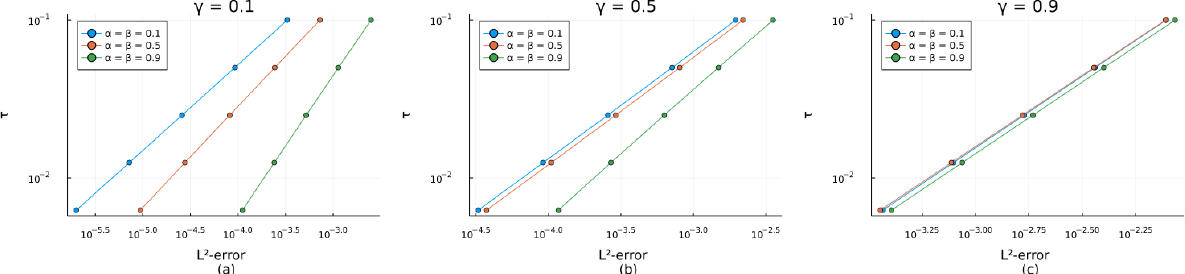
Figure 1. Error plots with respect to the time step τ obtained for Example 1 with h = 1/20,000 and different orders of fractional derivatives: α ∈ { 0.1,0.5,0.9 } ; β = α ; ( a ) γ = 0.1. ( b ) γ = 0.5. ( c ) γ = 0.9.